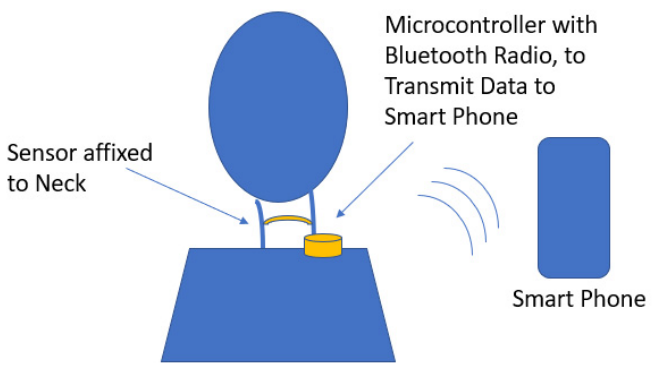
Figure 1. Prototype system’s component overview, with sensor placed on neck and wearable hard- ware placed on collar for communicating data to a smartphone for processing and for interfacing with the application.